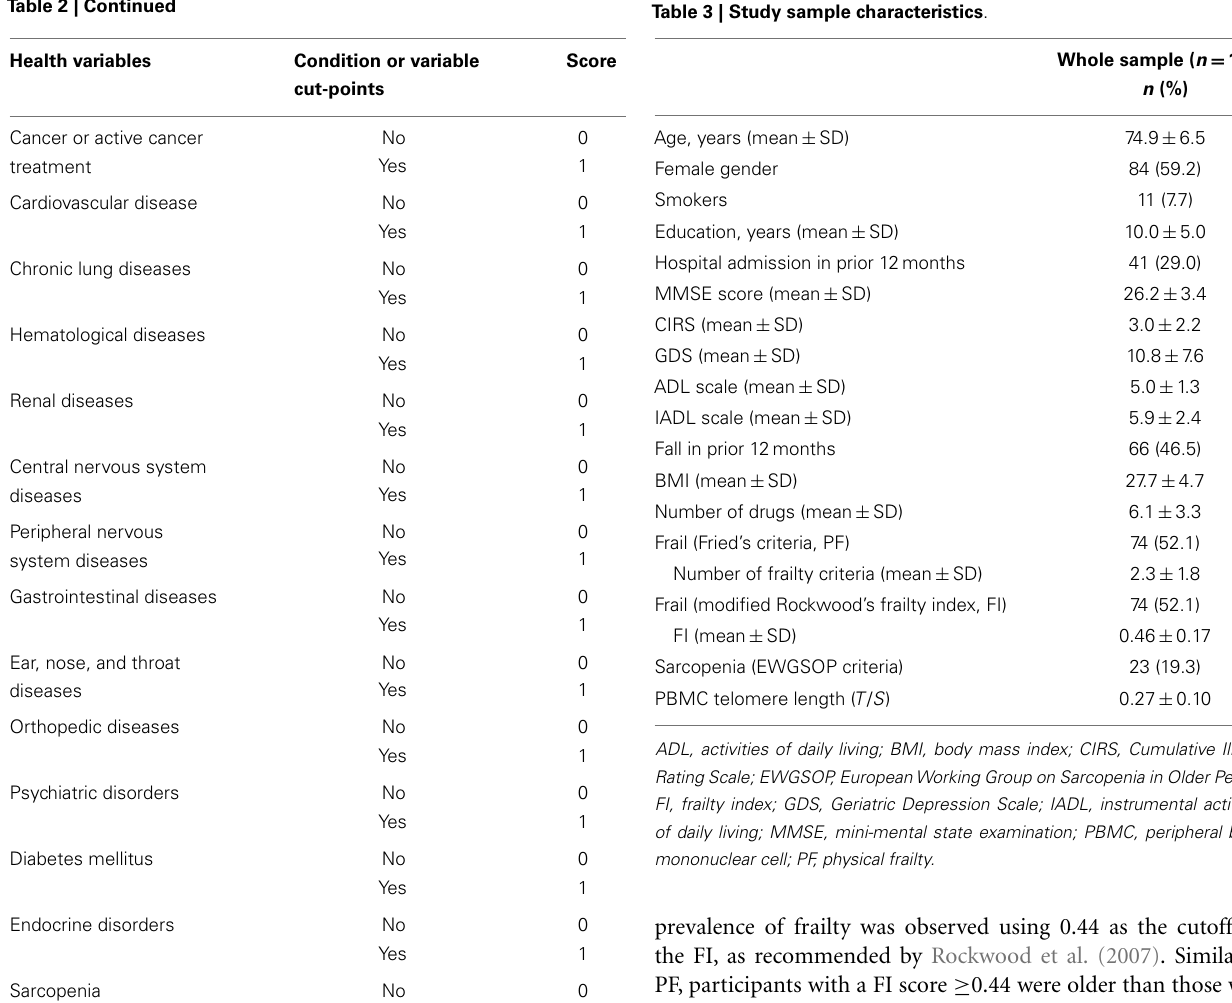
Table 3 | Study sample characteristics